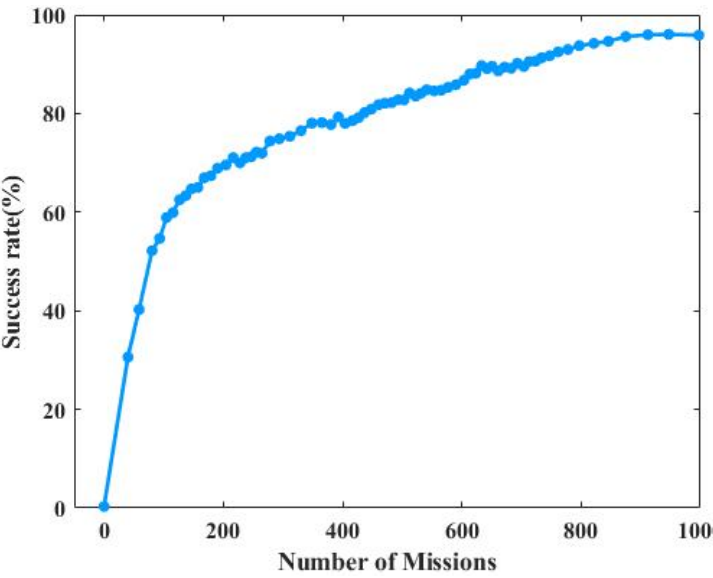
Figure 18. Success rate for the passed code checks . Figure 15. Success rate for the passed code